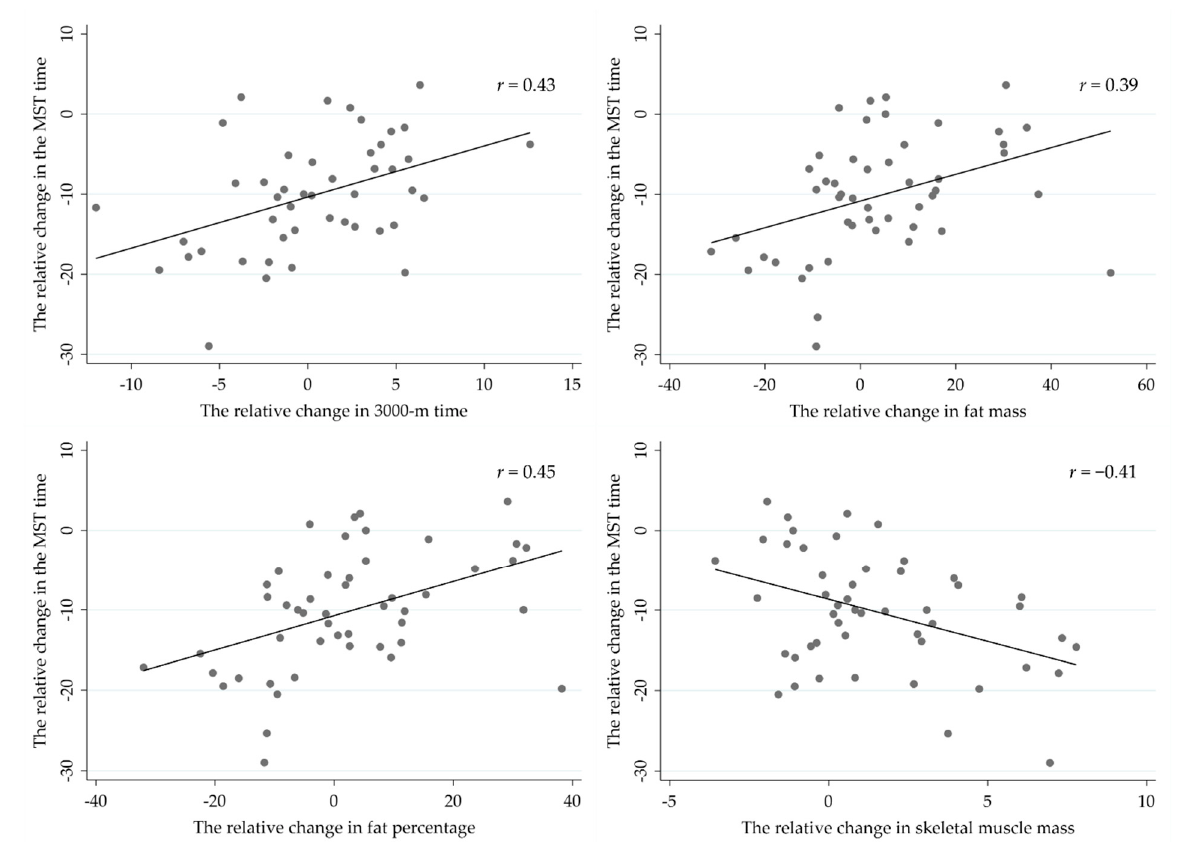
Figure 6 . Pearson correlations between the relative change in military simulation test (MST) and respective changes in body composition and the 3000-m running test.